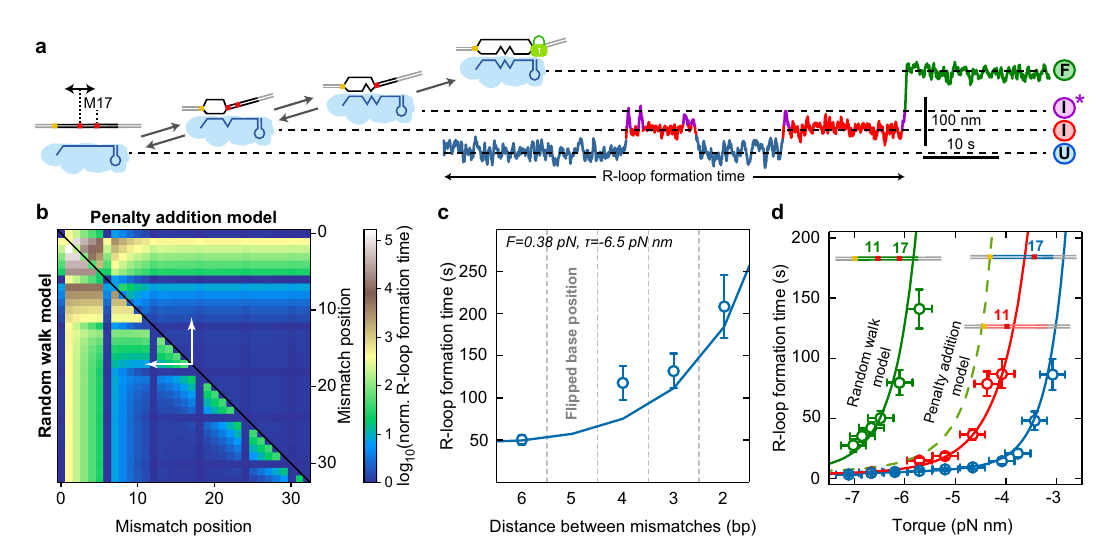
Fig. 6 | Locked R-loop formation on targets containing double mismatches. a Sketch of the DNAconstruct containing a fi rst C:C mismatchatpositions varying from11to15and asecondC:C mismatchatposition17(left).Exampletrajectory of full R-loop formation with the fi rst mismatch located at position 11 containing two intermediate states I and I * . b Predicted R-loop formation time for double mis- matches relative to the matching target using the penalty for a C:C mismatch and torque of − 6.5pNnm. Either the penalty addition model (upper right half) or the random walk model (lower left half) was applied. For mutations at positions 6, 12, 18,24,and30nopenaltieswereconsideredduetothedisruptedbase-pairinginthe crRNA – DNA hybrid. White arrows indicate the range of considered mismatch dis- tances between positions 11 and 17. c Experimental R-loop formation times on